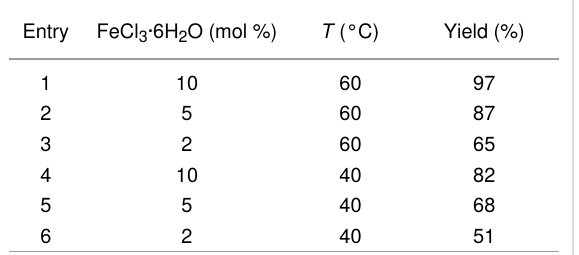
Table 2: Variation of catalyst load and reaction temperature a .